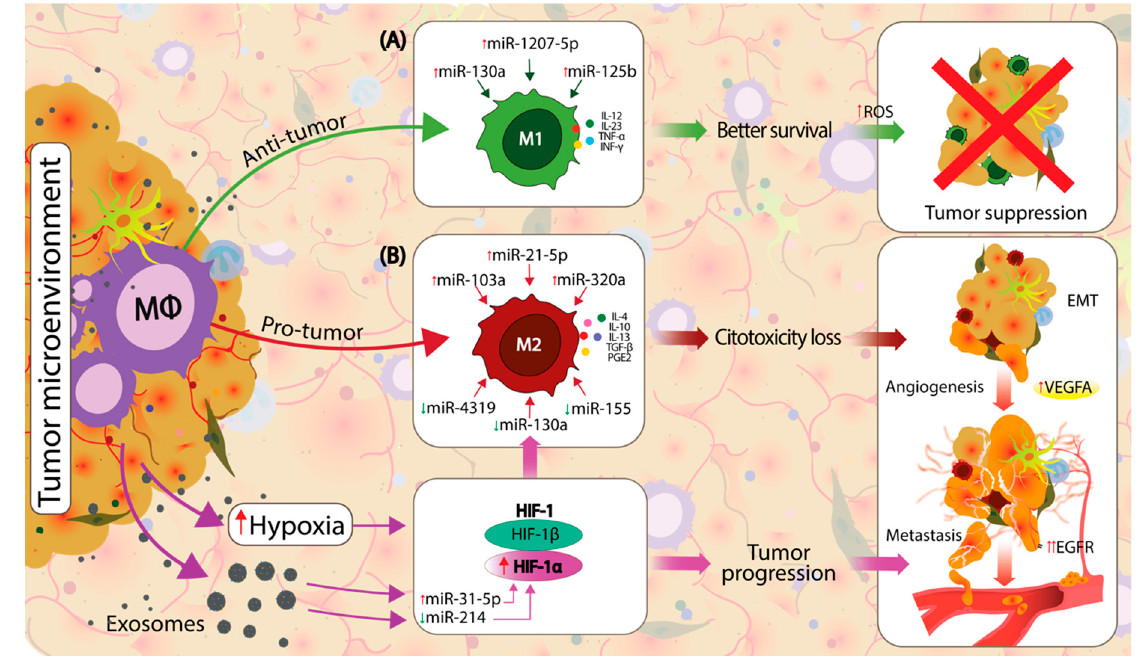
Figure 2. Macrophage polarization in the TME is influenced by local factors towards an M1 proinflammatory, antitumor or towards an M2 protumor, anti-inflammatory state. Cancer and TME cells directly influence the macrophage phenotypic dynamics by modifying the composition of secreted exosomes, which circulate the noncoding RNAs (ncRNAs), microRNAs (miRNAs) and other molecules between cells. ( A ) The upregulation of miR-130a, miR-1207-5p and miR-125b direct the macrophage polarization towards an M1 phenotype in non-small cell lung cancer (NSCLC), which will express M1 proinflammatory markers such as interleukin (IL)-12, IL-23, TNF- α and interferon gamma (IFN- γ ), which further increase the reactive oxygen species (ROS), leading to efficient tumor suppression. The local TME is a hypoxic environment that stimulates the upregulation of hypoxia-inducible factor 1 (HIF-1) genes. Hypoxia-inducible factor 1-alpha (HIF-1 α ) is upregulated by local hypoxia and by an upregulation of miR-31-5p and downregulation of miR-214. HIF-1 α is a known modulator of M2 macrophage polarization. ( B ) Polarization towards the M2 phenotype is acquired by the direct influence of HIF-1 α and various dysregulated miRNAs from the local TME, including the upregulation of miR-103a, miR-21-5p and miR-320a and downregulation of miR-4319, miR-130a and miR-155. M2-polarized macrophages express specific markers, such as IL-4, IL-10, IL-13, TGF- β and PGE2, which further support the pro-neoplastic processes. HIF-1 α and M2 macrophages support the tumor progression by enhancing the epithelial-to-mesenchymal transition (EMT), angiogenesis and metastasis.